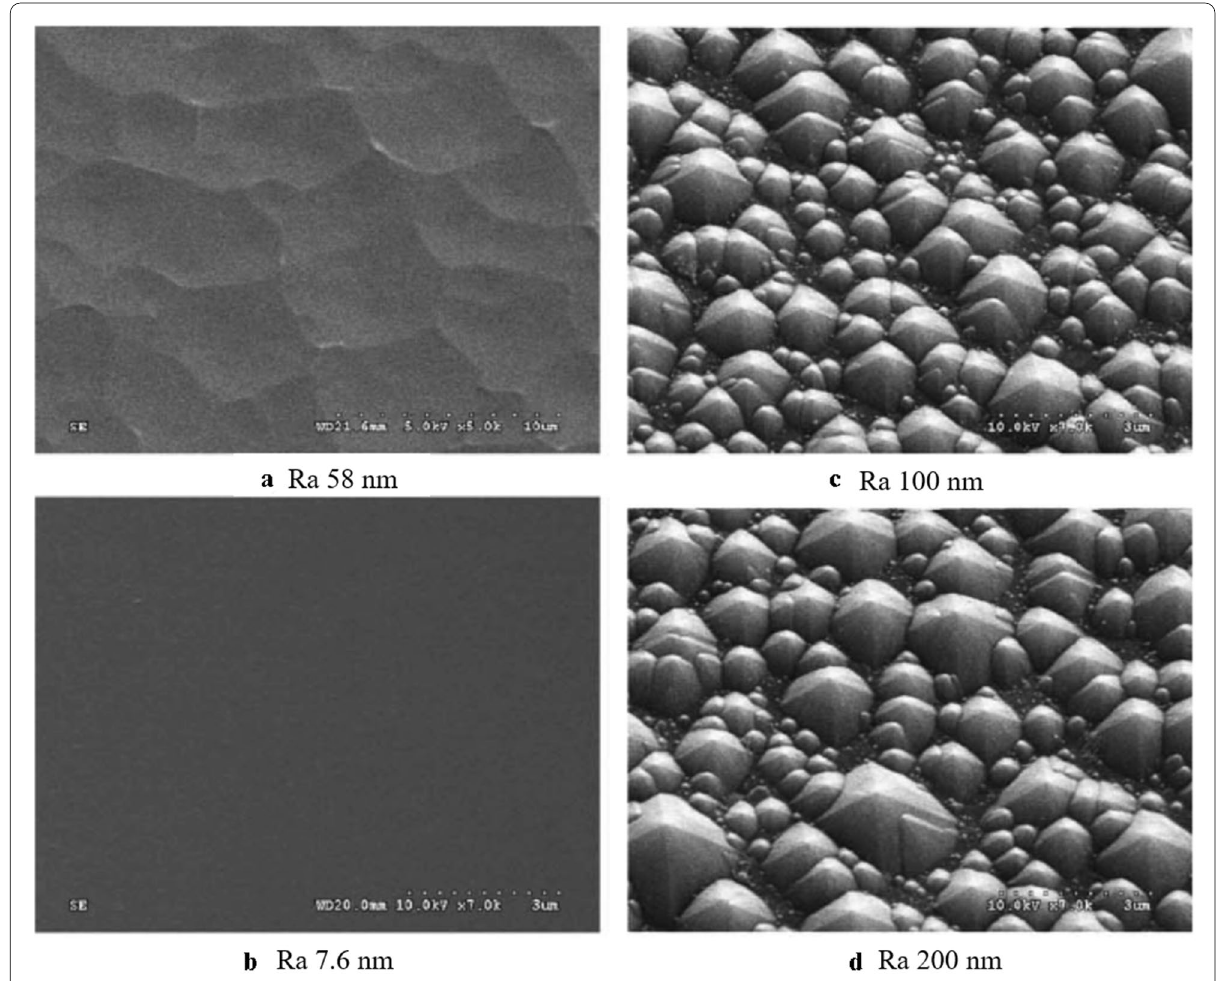
Fig. 35 SEM micrographs and average roughness of etched surfaces in pure and SDSS-added 30 wt% KOH and 10 wt% TMAH at 90 °C: a pure KOH, b KOH SDSS, c pure TMAH, d TMAH SDSS [56], © 2005, + +